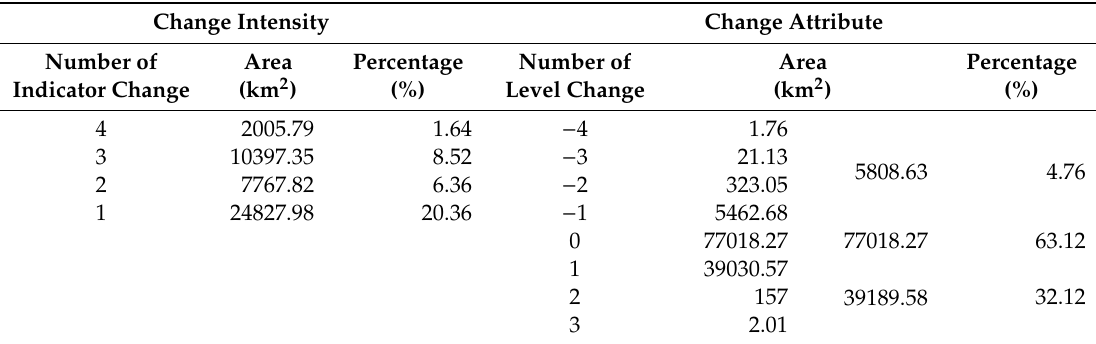
Table 5. Statistics of change intensities and attributes in the period 2002–2017.